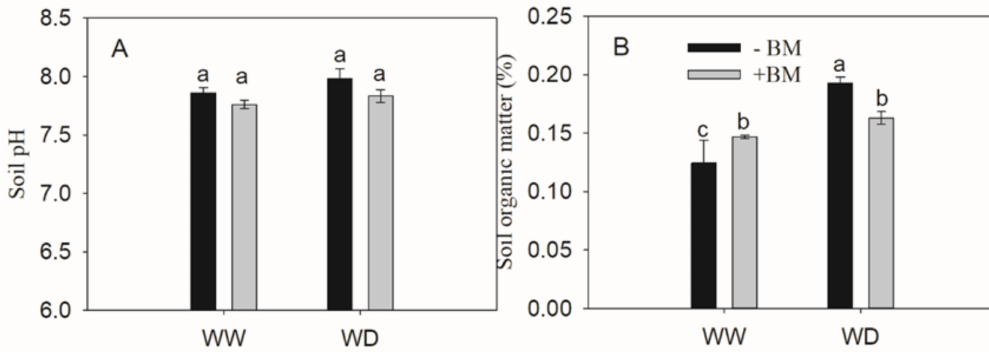
Figure 7. Effect of BM application on soil pH ( A ) and organic matter ( B ) under two water status. WW and WD show the different soil water contents. The different letters indicate significant difference ( p <